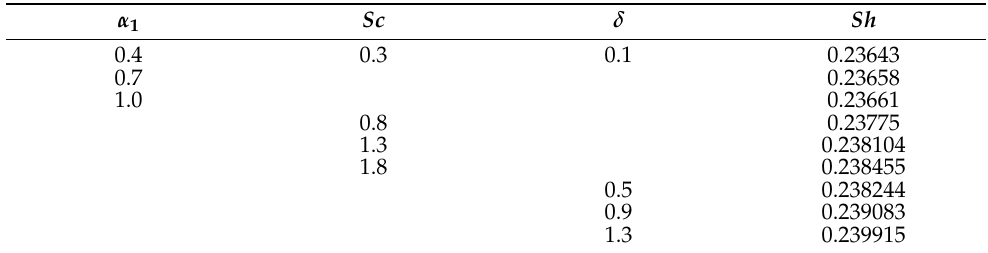
Table 4. Numerical values of Sherwood number with varying values of the parameters α 1 , Sc , δ